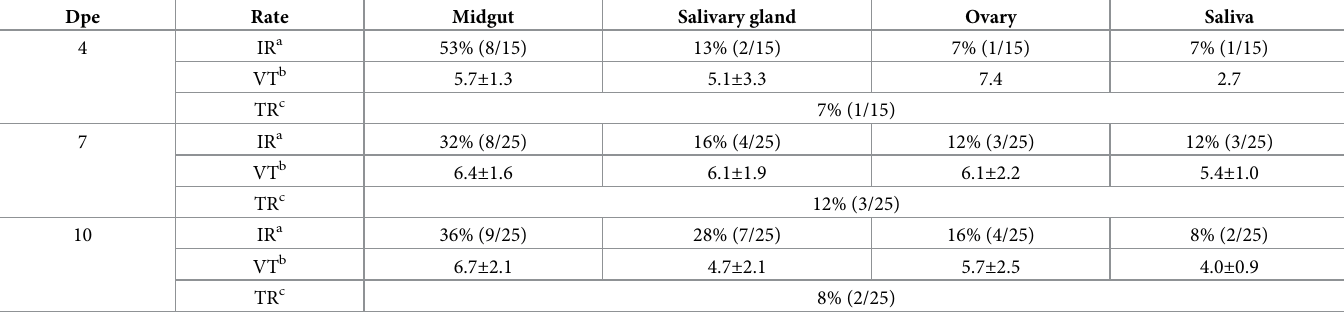
Table 1. ZIKV infection rate and quantification of Zika viral RNA copies, by real-time RT-PCR, detected in the salivary gland, midgut, ovary and collected saliva of Ar . subalbatus females at 4, 7, and 10 dpe (blood meal).